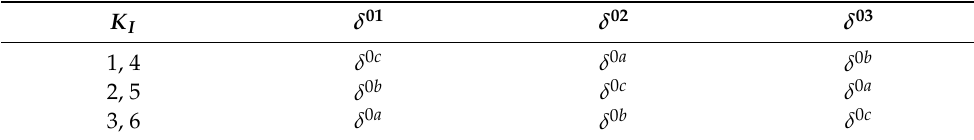
Table 3. Zero states to select according the input current sector.